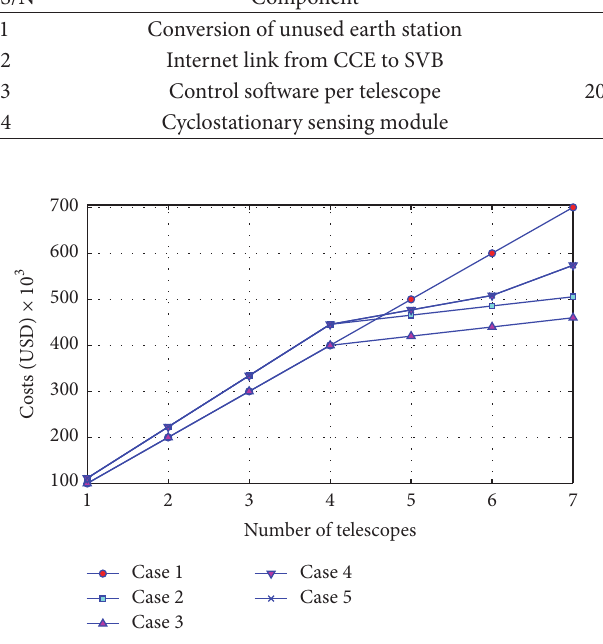
Figure 11: Terrestrial radio astronomy organisation angular resolu-